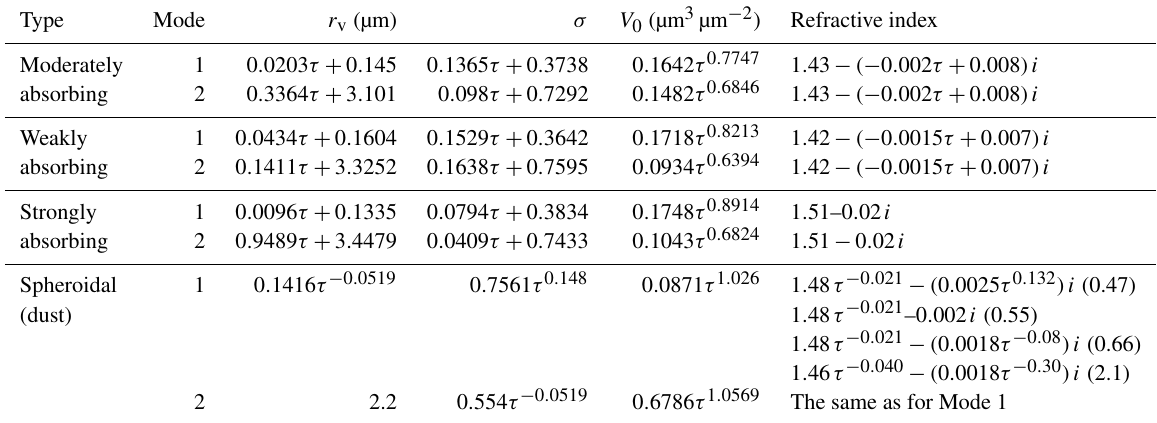
Table 2. Parameters of PSD function and refractive indices of the DT-land aerosol types according to Levy et al. (2007).